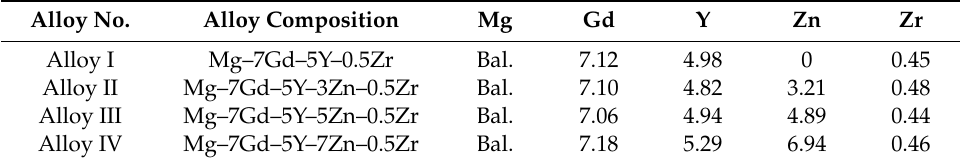
Table 1. The actual compositions of as-cast Mg–7Gd–5Y– x Zn–0.5Zr alloys (wt%). Alloy